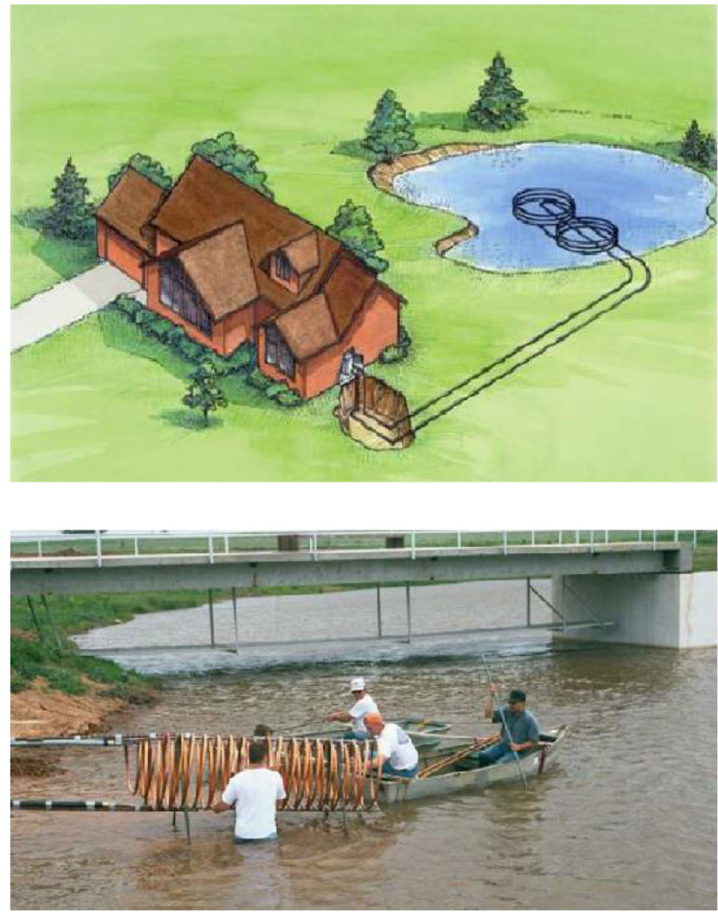
Fig. 3 Surface water GSHPs